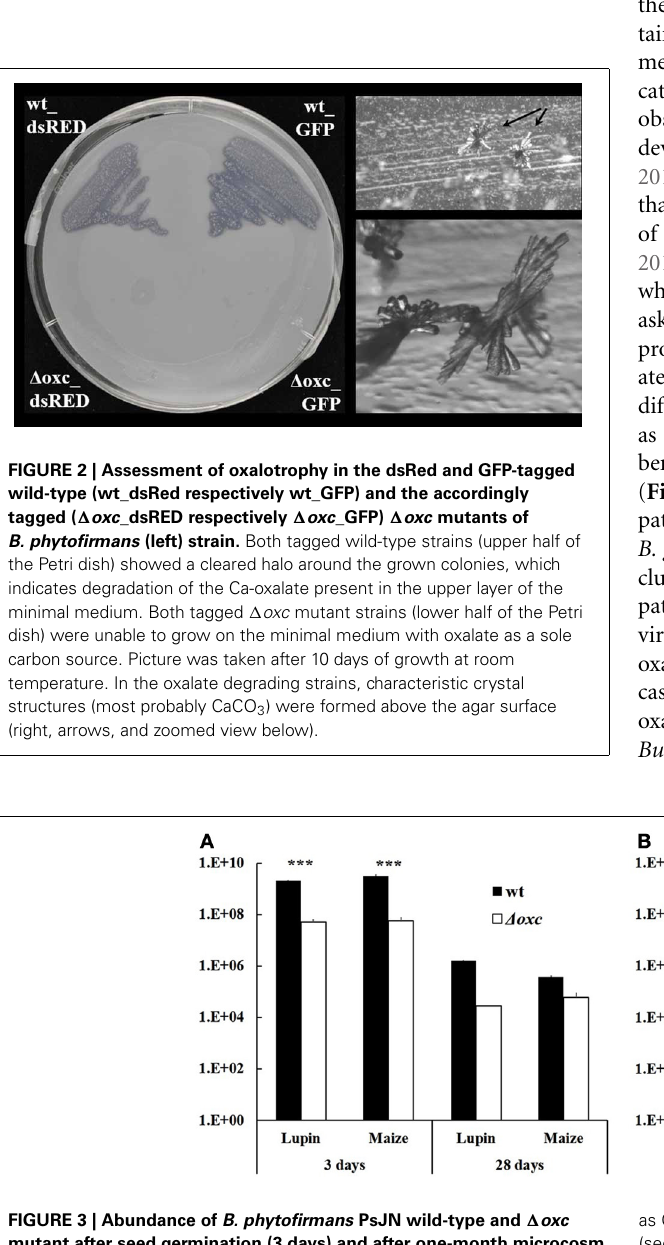
as CFU per g root fresh weight after 28 days. Average of 2–3 replicates (seeds/plants) are shown, with the exception of one case, where no mutant cells were retrieved in two out of three replicate plants ( A , lupin, 28 days, (cid:2) oxc ). Stars indicate significant differences between wild-type and mutant (Student’s t -test, n = 2–4, ∗ P < 0 . 05, ∗∗∗ P < 0 .